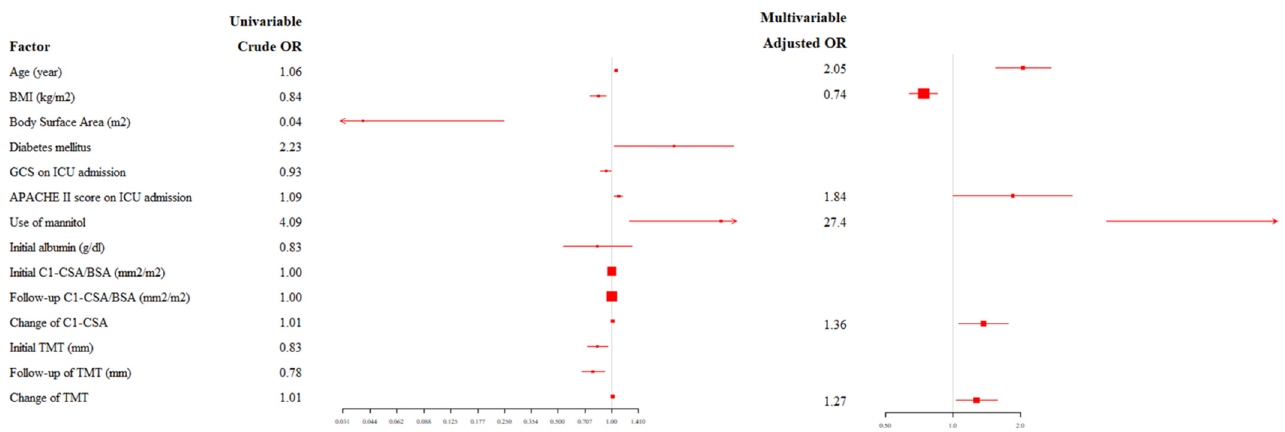
Figure 5. Forest plot of the regression model. Abbreviations: BMI, body mass index; GCS, Glasgow Coma Scale; ICU, intensive care unit; APACHE, Acute Physiology and Chronic Health Evaluation; BSA, body surface area; Change of C1-CSA, 100 × (initial C1-CSA minus follow-up C1-CSA/initial C1-CSA); and change of TMT, 100 × (initial TMT minus follow-up TMT)/initial TMT.